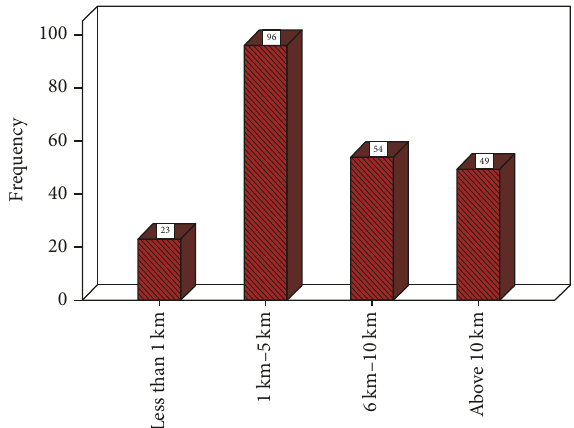
Figure 2: Nearest health centre from